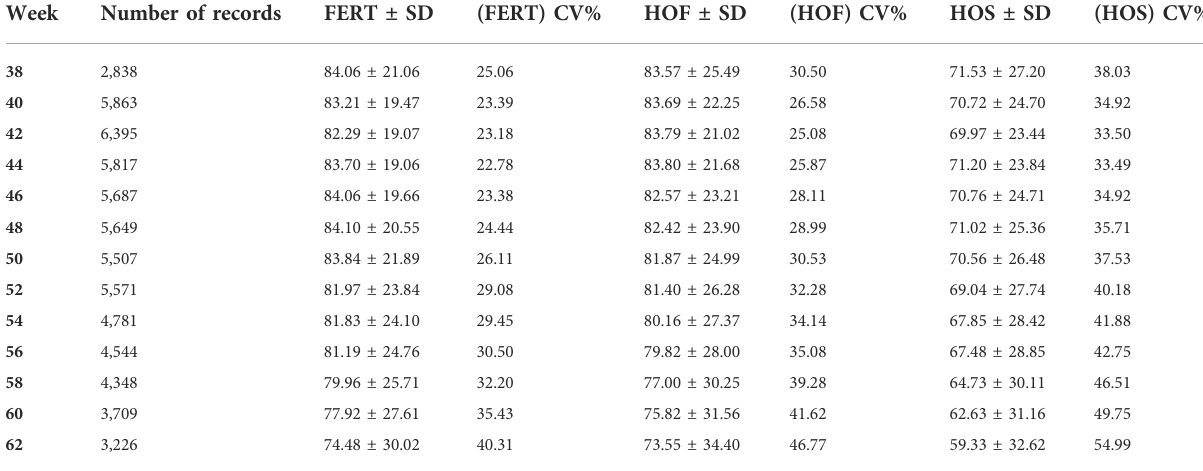
TABLE2 Descriptivestatisticsforhatchofset(HOS),hatchoffertile (HOF),andfertility ofset(FERT) including thenumberofrecords,mean, standard deviation (SD), and coef fi cient of variation (CV) for the different time points (38 – 62 weeks). Week Number of